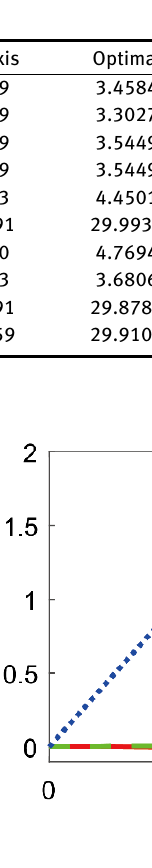
Figure 11. Nondimensional angular velocity histories for Case